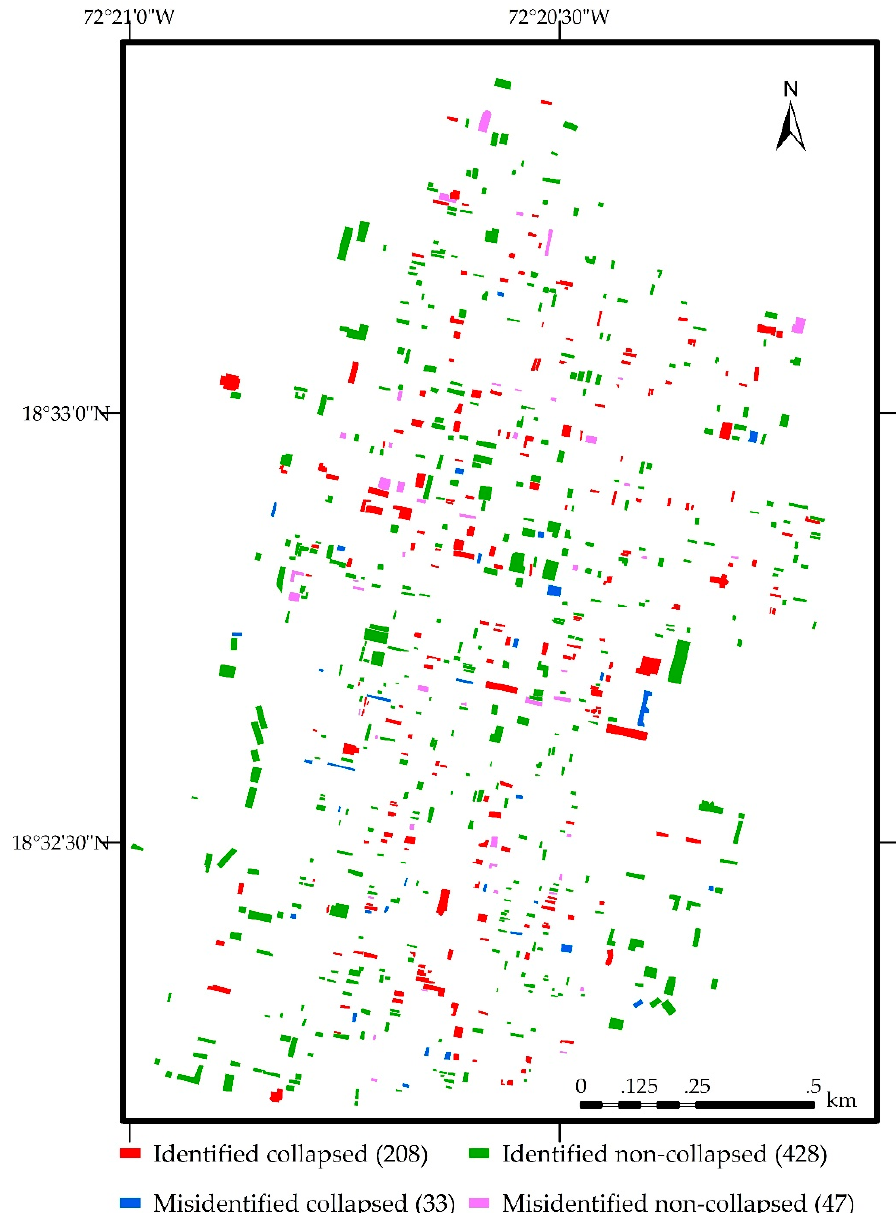
Figure 6. Performance of pretrained VGGNet model for discriminating collapsed and non-collapsed buildings.